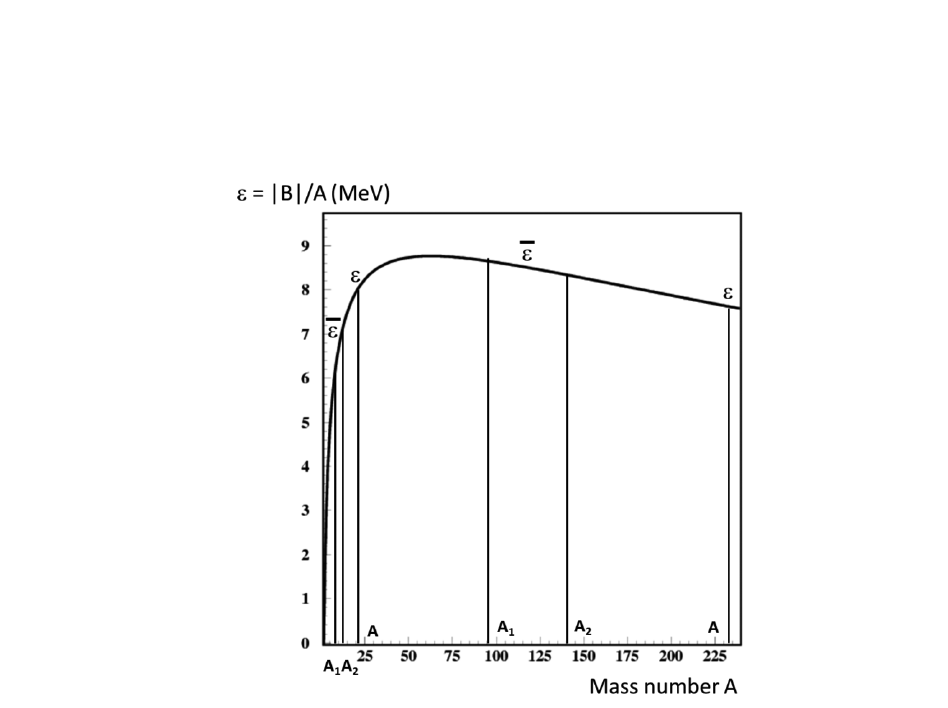
Fig. 1. – Absolute value of binding energy per nucleon, as a function of the mass number A